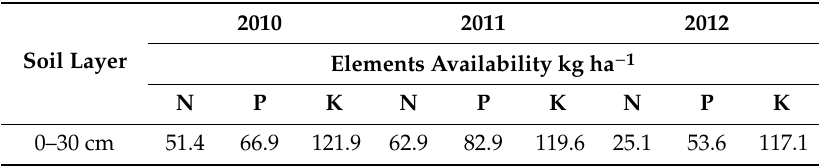
Table 2. Macro elements availability before maize